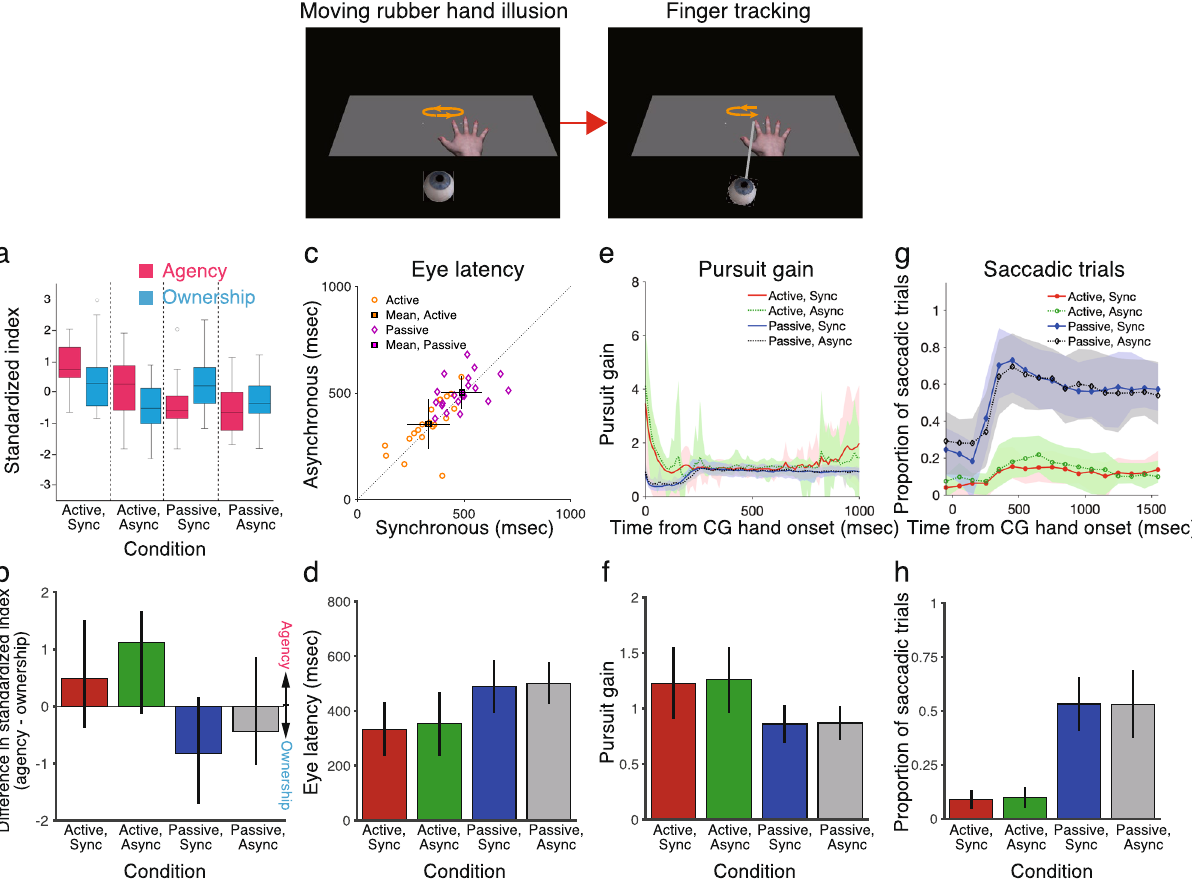
Figure 2. Results of experiment 1. ( a , b ) Strength of the rated ownership and agency of the computer graphics (CG) hand shown as box-and-whisker plots for the four conditions. The ownership and agency indexes were defined as the difference in ratings between the illusion and control questions. ( a) The standard score (z-score) was calculated for each of the ownership (blue) and agency (pink) indexes, which were defined as the standardized index. Horizontal black bars represent medians, and the boxes denote the interquartile ranges. Whiskers extend to the farthest data points within 1.5 times the interquartile range from the top and bottom edges of the boxes. Individual open circles represent outliers. ( b) The standardized ownership index was subtracted from the standardized agency index. Colored bars represent the medians, and the error bars represent the interquartile ranges. ( c , d ) Eye latency, as defined by eye onset time relative to CG hand onset time. Orange and purple symbols represent the active and passive hand movement conditions, respectively, for individual participants. Square symbols represent the mean ± standard deviation. ( e , f ) Pursuit gain, defined as eye velocity divided by CG hand velocity after excluding saccades in velocity traces. ( e ) Shaded areas represent standard deviation. ( f ) Shows the average pursuit gain in the range of 0 to 1000 ms. ( g , h ) Proportion of saccadic trials in the range of − 200 to 1600 ms from CG hand onset. Results are the mean ± standard deviation in Figs. 2d–h ( n =